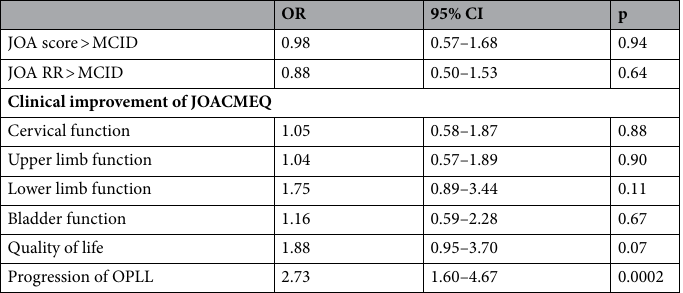
Table 5. Logistic regression analysis for postoperative functional outcome and progression of OPLL in in the weighted sample of patients undergoing laminoplasty or posterior spinal fusion. Weighted for IPTW and further adjusted for baseline age, sex, VAS (pain or numbness in the arms or hands), preoperative JOACMEQ (bladder function), preoperative comorbidity (cerebrovascular disease). JOA Japanese Orthopaedic Association, JOACMEQ Japanese Orthopaedic Association Cervical Myelopathy Evaluation Questionnaire, OR odds ratio, CI confidence intervals, OPLL ossification of the posterior longitudinal ligament, MCID minimum clinically important difference, IPTW inverse probability of treated weighting, VAS visual analogue